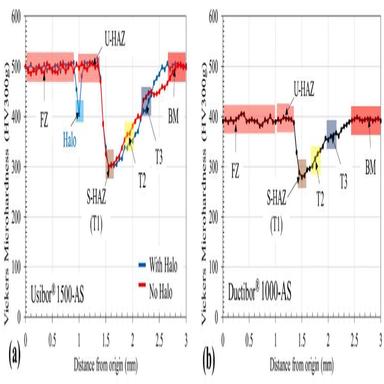
Spot weld region discretization based in hardness and definition of local material conditions for (a) Usibor® 1500-AS, and (b) Ductibor® 1000-AS.